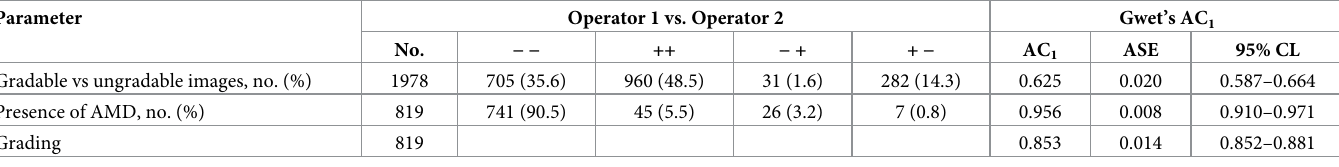
Table 2. Inter-operator agreement on fundus photos analysis.